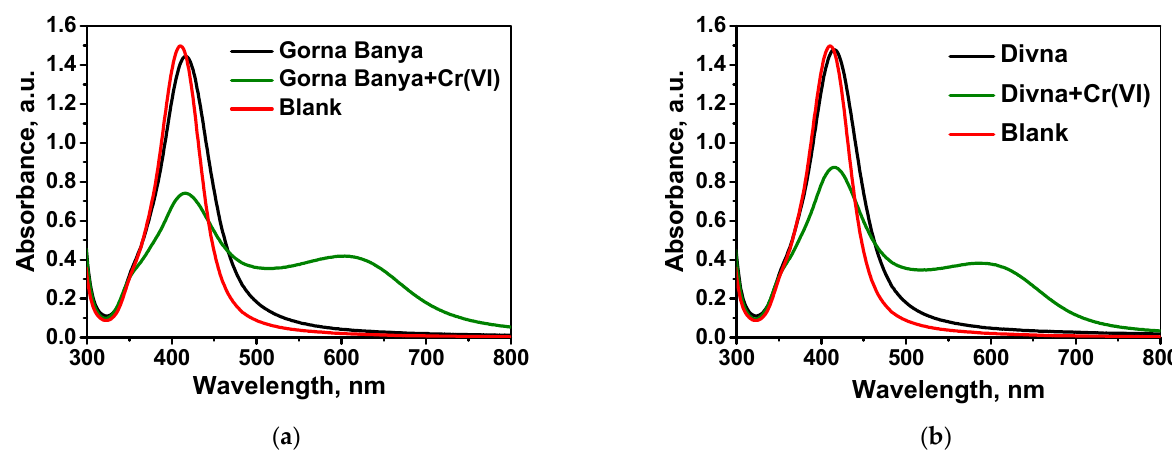
Figure 8. Response of the optical sensor to natural water samples without addition and with addition of standard solution of Cr(VI): ( a ) Gorna Banya mineral water; ( b ) Divna spring water.